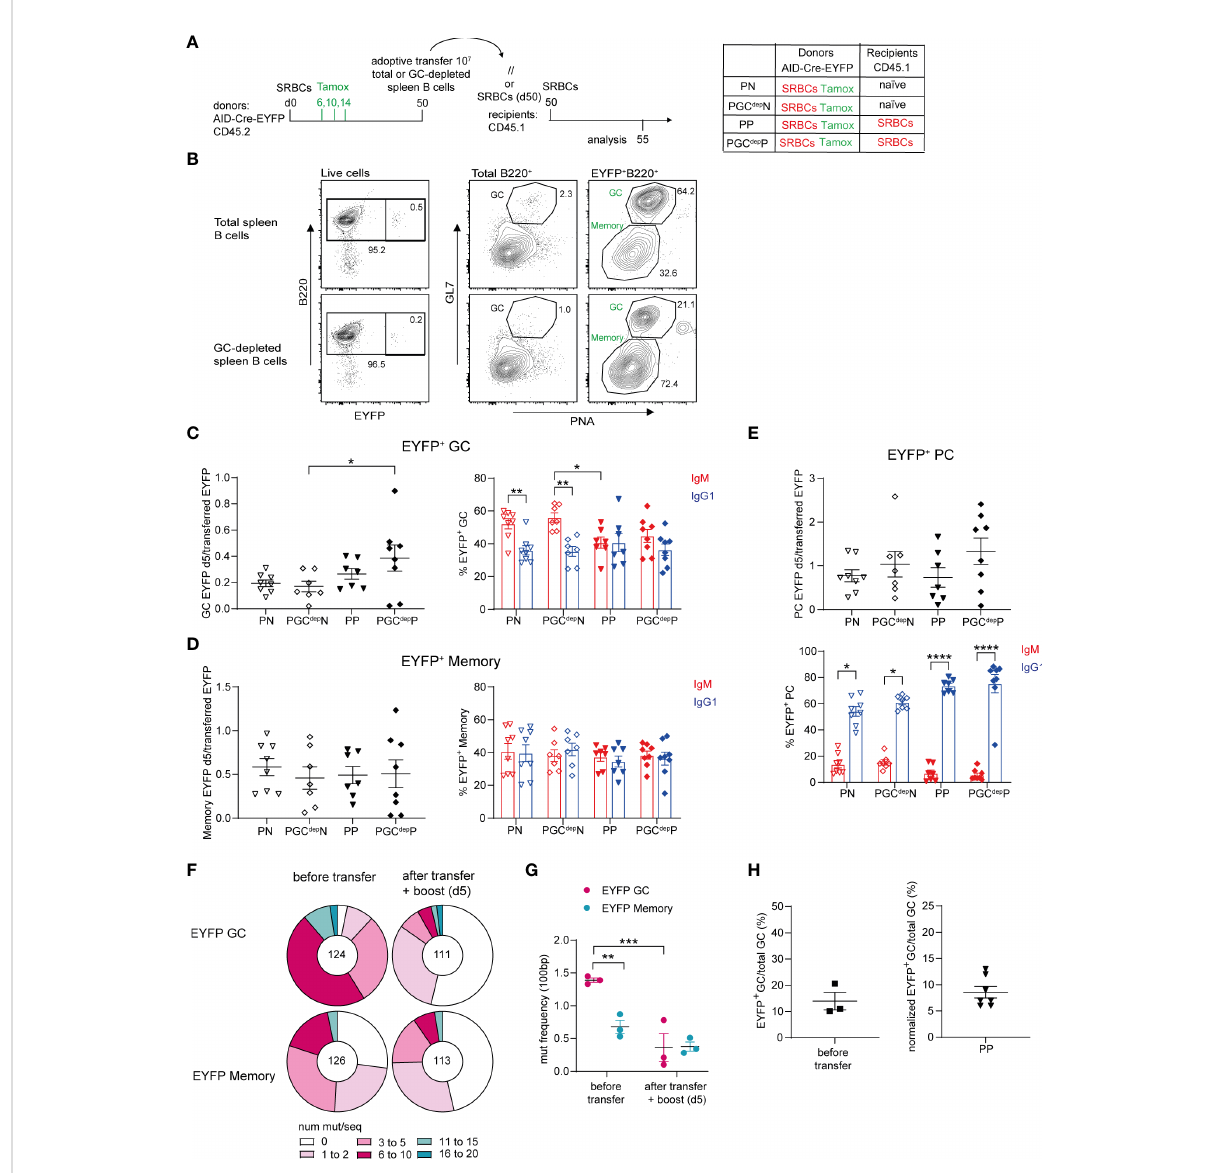
FIGURE 3 Recruitment of MBCs into recall GC responses. (A) 10 x10 6 total or GC-depleted puri fi ed splenic B cells (obtained by magnetic bead depletion of PNA + and GL7 + cells) from SRBCs-primed AID-Cre-EYFP donor mice (d50) that received tamoxifen on d6,10,14 were adoptively transferred into naive or primed (d50) wt CD45.1 recipient mice. Host mice were injected with SRBCs 2 hours after adoptive cell transfer and spleens were analyzed 5 days after SRBC challenge. (B) Representative fl ow cytometry pro fi le of splenic cells adoptively transferred from the total B cell pool and the GC-depleted one showing the reduction of the GL7 + PNA + fraction in both total and EYFP + B cells in the GC-depleted population. EYFP + GC (C) , memory (D) , and PC (E) cell numbers (normalized on total EYFP + injected cells) and their IgM and IgG1 isotype distribution are shown in the graphs. (F) Distribution of sequences with a given number of mutations in rearranged intronic J H4 sequences from EYFP + PNA + GL7 + GC and EYFP + PNA - GL7 - memory cells from AID-Cre-EYFP SRBC-primed (9 weeks) donor mice that received tamoxifen on d6,10,14 (before transfer) and from SRBC-primed (9 weeks) wt CD45.1 recipient mice that received IgD-depleted B cells from the same donors and were challenged with SRBCs after cell transfer (after transfer + boost (d5)). The total number of analyzed sequences is indicated in each corresponding pie charts. (G) Mutation frequencies were calculated per 100 bp and are shown in the scatter plot. (H) Estimate of MBC contribution to recall GCs. The left panel represents the frequency of EYFP + GC B cells on total GC B cells calculated from 3 pools of donor splenic B cells before adoptive transfer (experimental setting adopted in panel (A) , re fl ecting the labeling ef fi ciency of our reporter mouse. The right panel shows the frequency of EYFP + GC counts on total GC B cells 5 days after adoptive transfer in the condition of total B cell transfer from primed donors into primed hosts (PP), after normalization for the 14% GC labelling ef fi ciency observed after three tamoxifen gavages as calculated in the left plot. Each point in the graphs represents an individual mouse from at least two independent experiments. Means ( ± SEM) are shown. Kruskal-Wallis analysis with uncorrected Dunn ’ s test was performed to compare the different conditions in panels (C – E, G) *p<0.05, **p<0.01, ***p<0.001, ****p<0.0001. P, primed; N, naïve; GC dep , GC